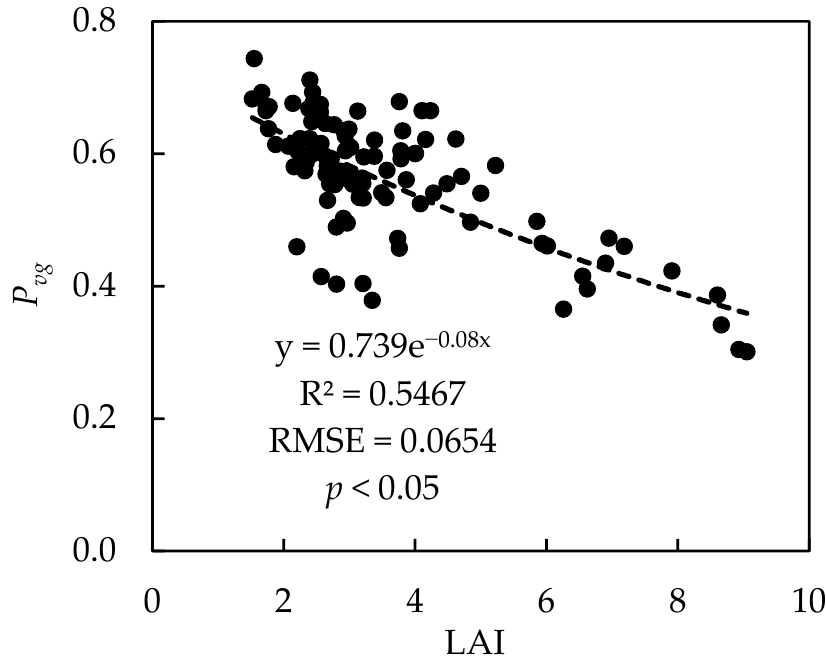
Figure 7. Scattering plot between P vg and LAI.